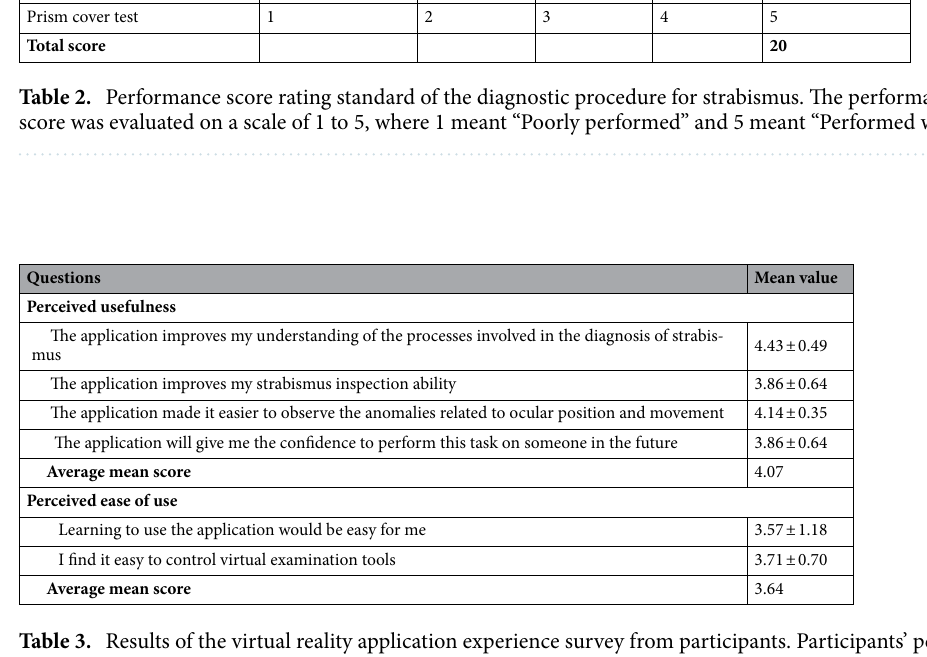
Table 3. Results of the virtual reality application experience survey from participants. Participants’ perception of virtual reality applications was quantitatively evaluated on a scale of 1 to 5, where 1 meant “Disagree” and 5 meant “Agree”. Data were expressed as mean ± standard deviation unless otherwise